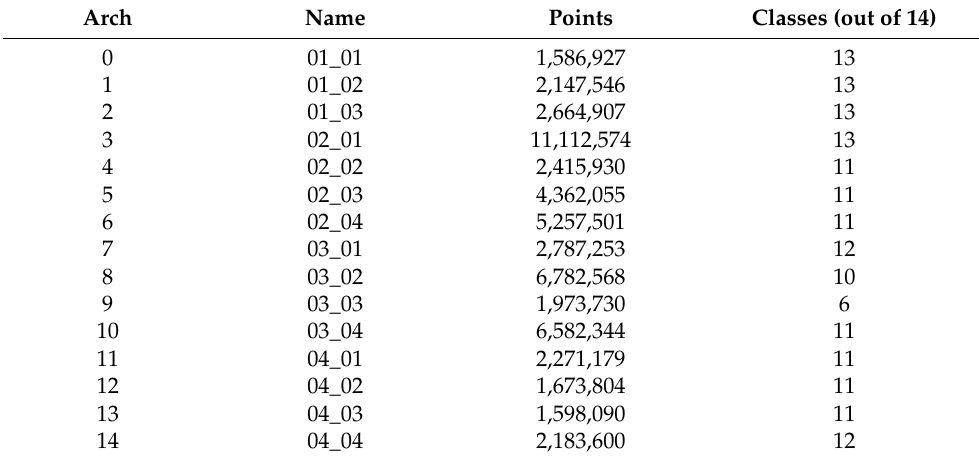
Table 1. Statistical description of the